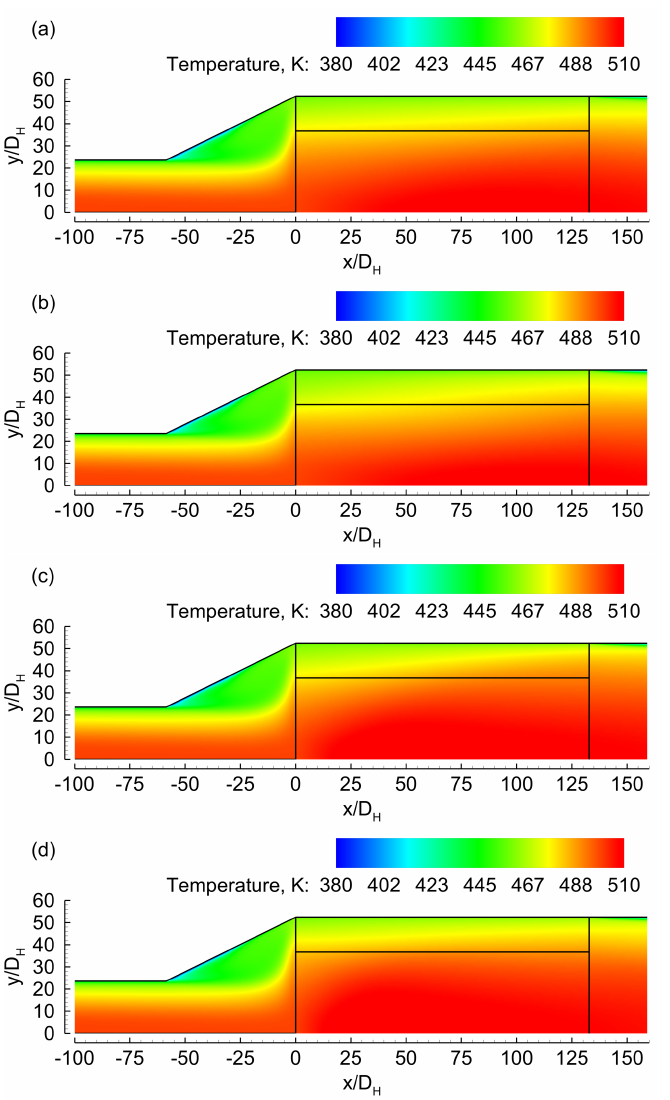
Figure 4. Temperature distribution. ( a ) 400c/400r, ( b ) 400c/900r, ( c ) 900c/900r, and ( d ) 900c/400r.